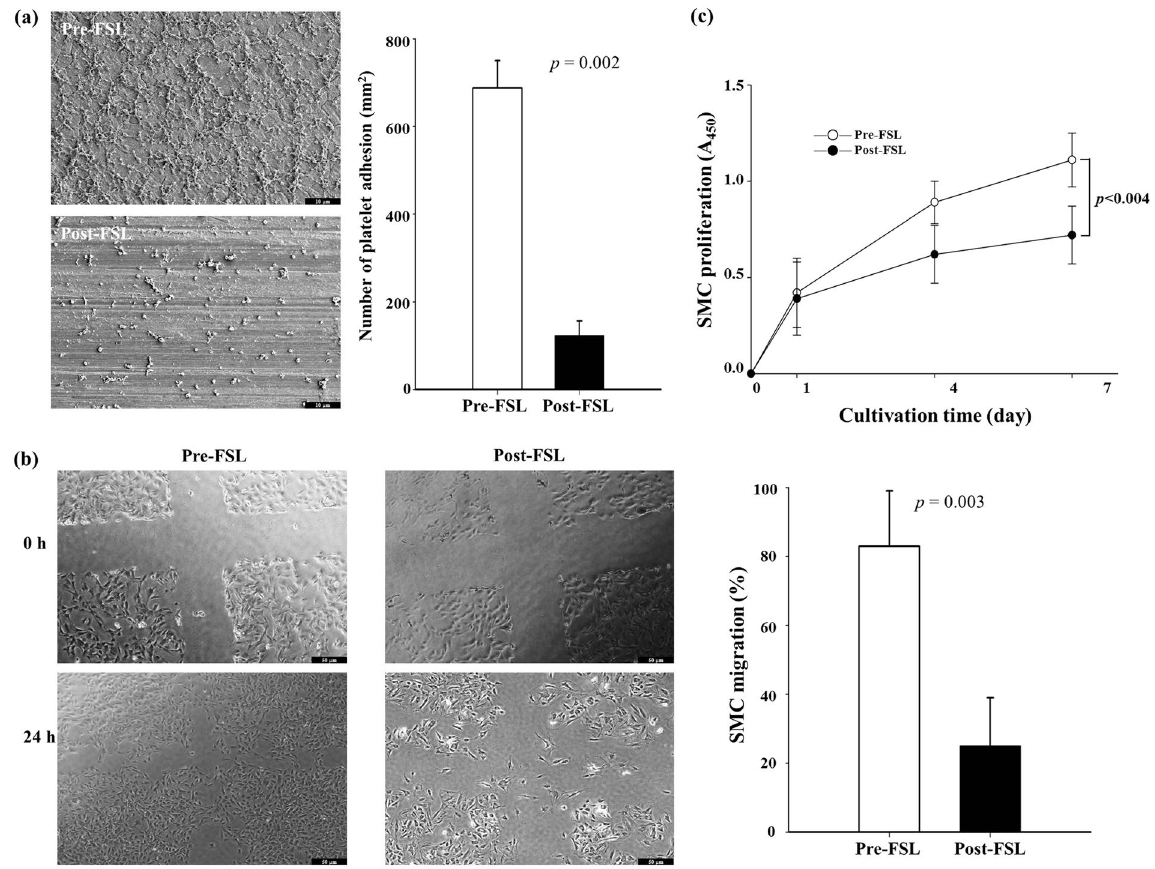
Figure 4. Platelet adhesion and smooth muscle cell response after femtosecond laser irradiation. Representative images and image analysis of platelet adhesion ( a ) and SMC migration ( b ) XTT analysis for SMC proliferation. ( c ) The indicated values are expressed as the mean ± SD (n = 10).